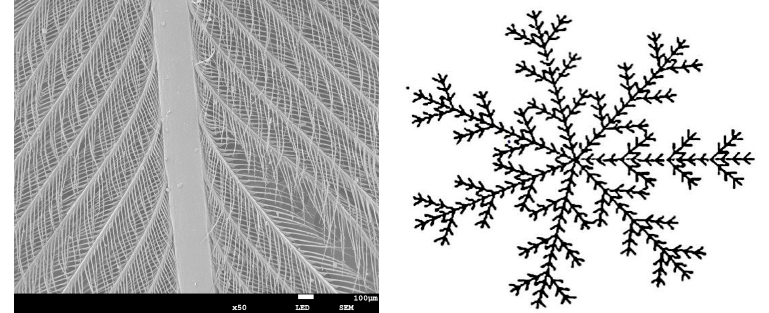
Figure 8. Self-similarity characteristic diagram of discarded feathers.